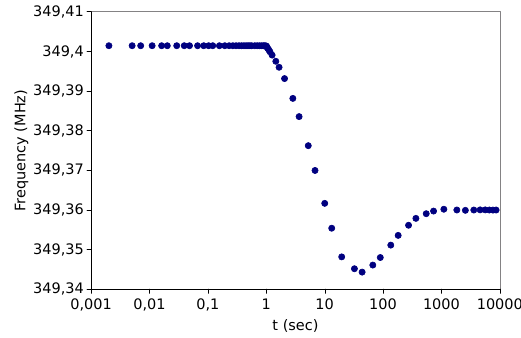
Figure 18. Frequency of the RFQ cavity (first segment) during a transient steps, from zero RF power to operation power at duty cycle 5 % (power up). Cavity frequency is computed at all times of the